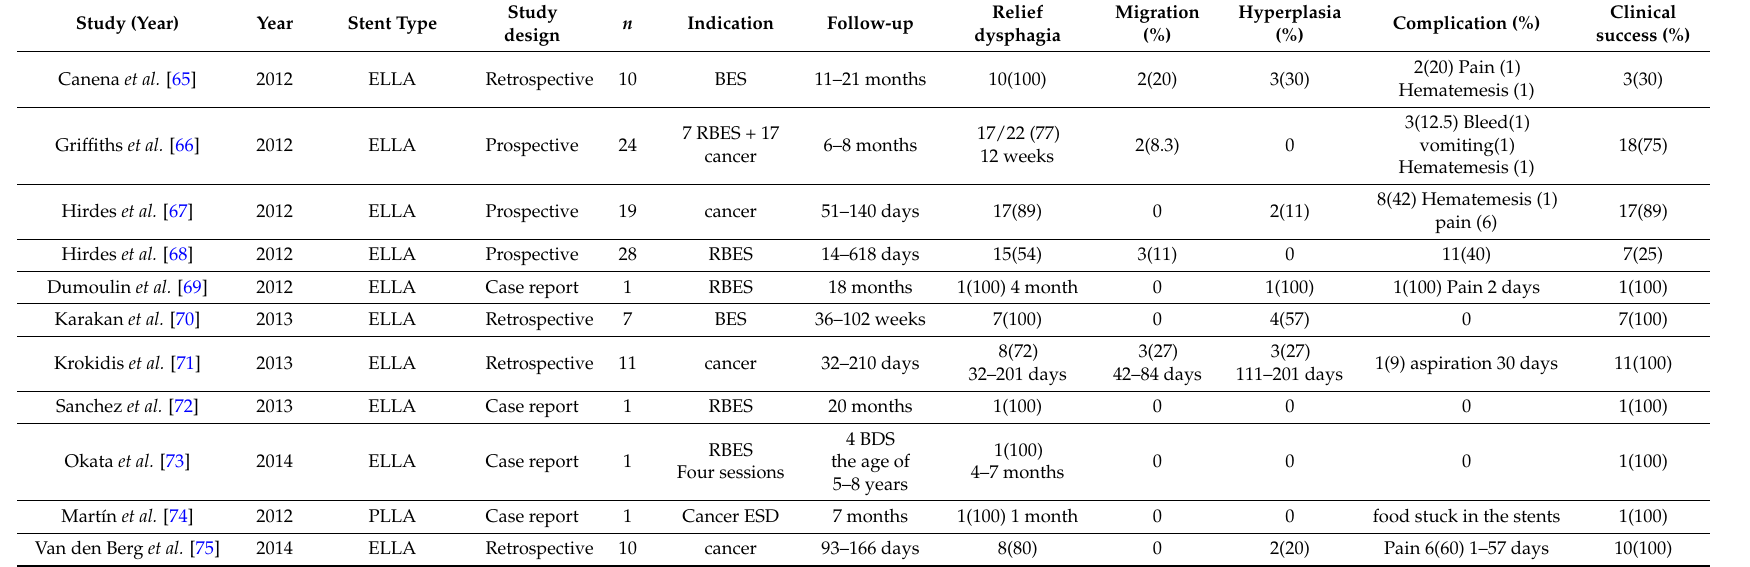
Table 1. Result of biodegradable stents in esophageal